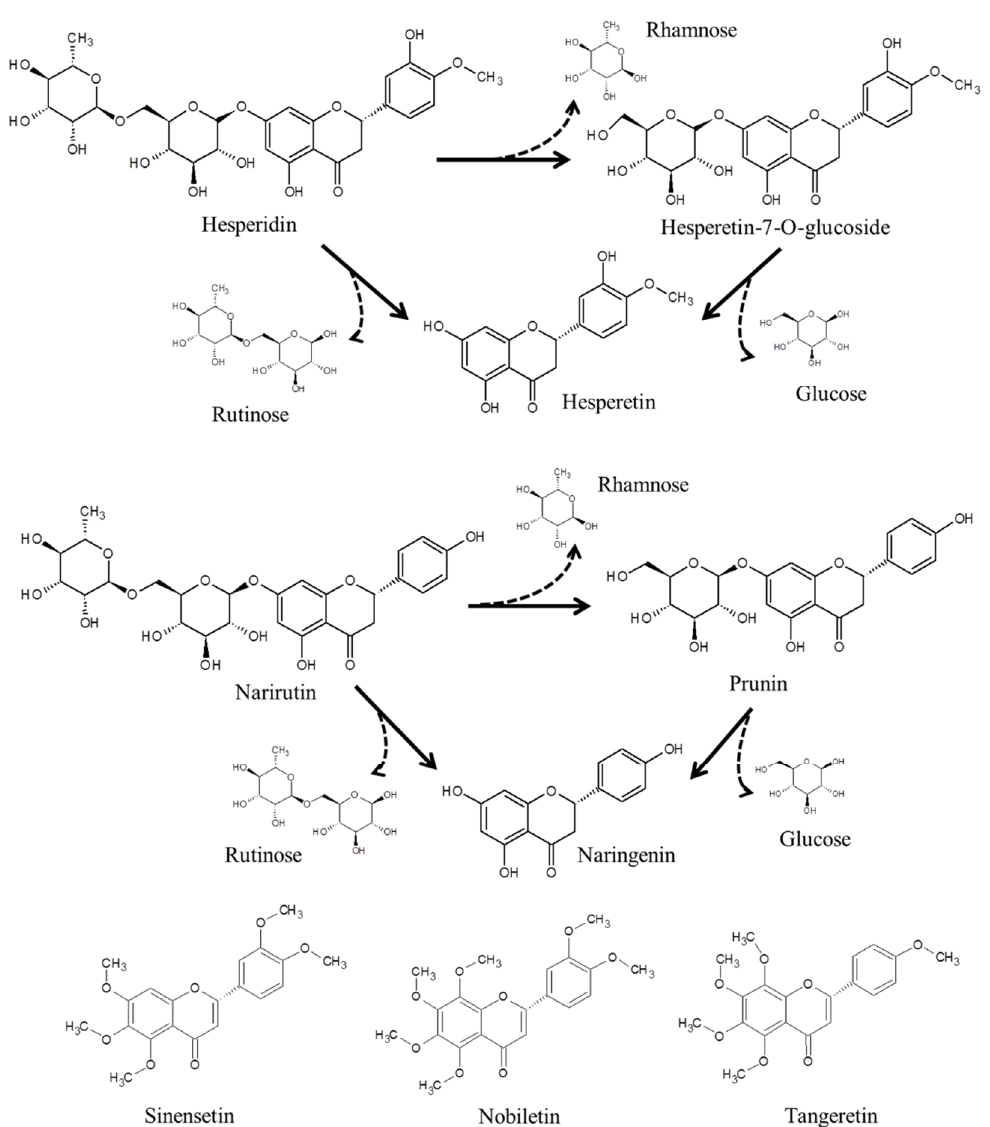
Figure 1. Chemical structures and hydrolysis pathways of citrus flavonoids.